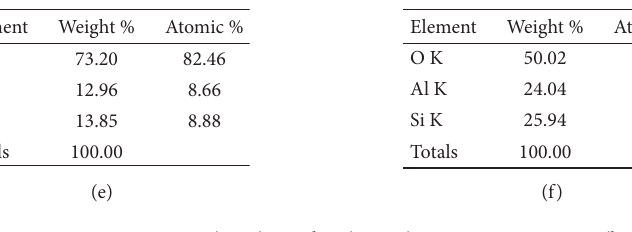
Figure 13: Energy Dispersive X-ray Spectroscopy (EDS) results: (a, c, e) room temperature; (b, d, f) after treatment at 600 °